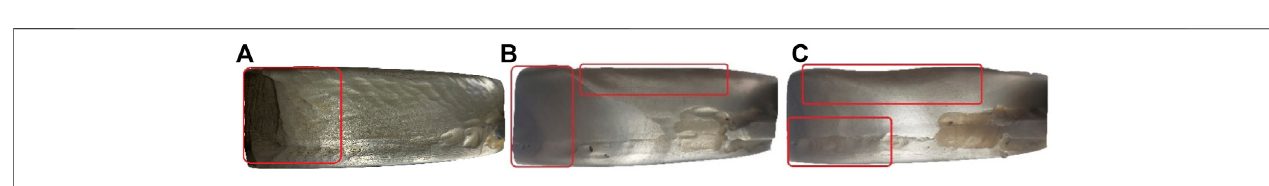
FIGURE 11 | Pressure surface wear under different particle sizes. (A) 0.125 – 0.212 mm, (B) 0.212 – 0.425 mm, and (C) 0.425 – 0.710